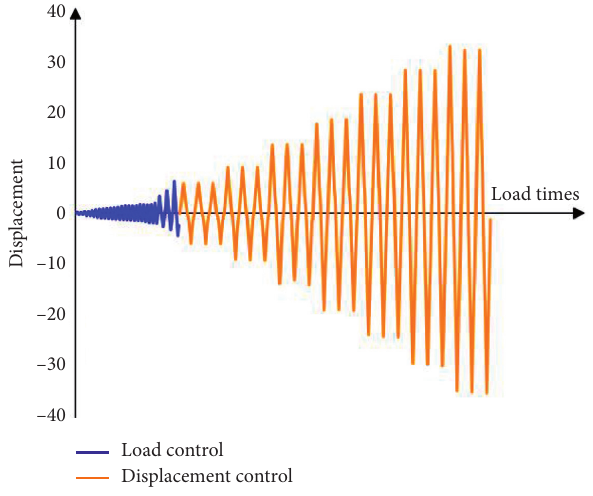
Figure 1: Loading